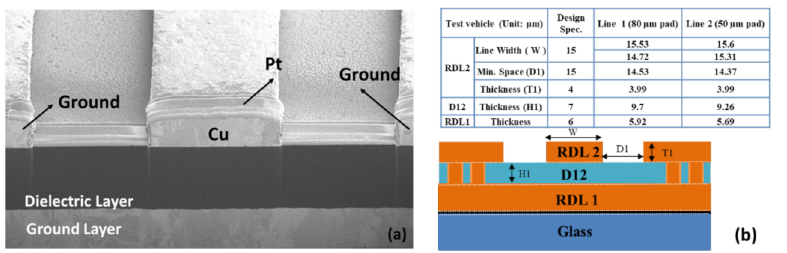
Figure 12. The schematic of test vehicle.